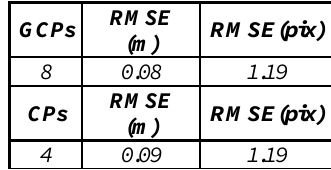
Table 2. Root Mean Square Error (RMSE) of GCPs and CPs